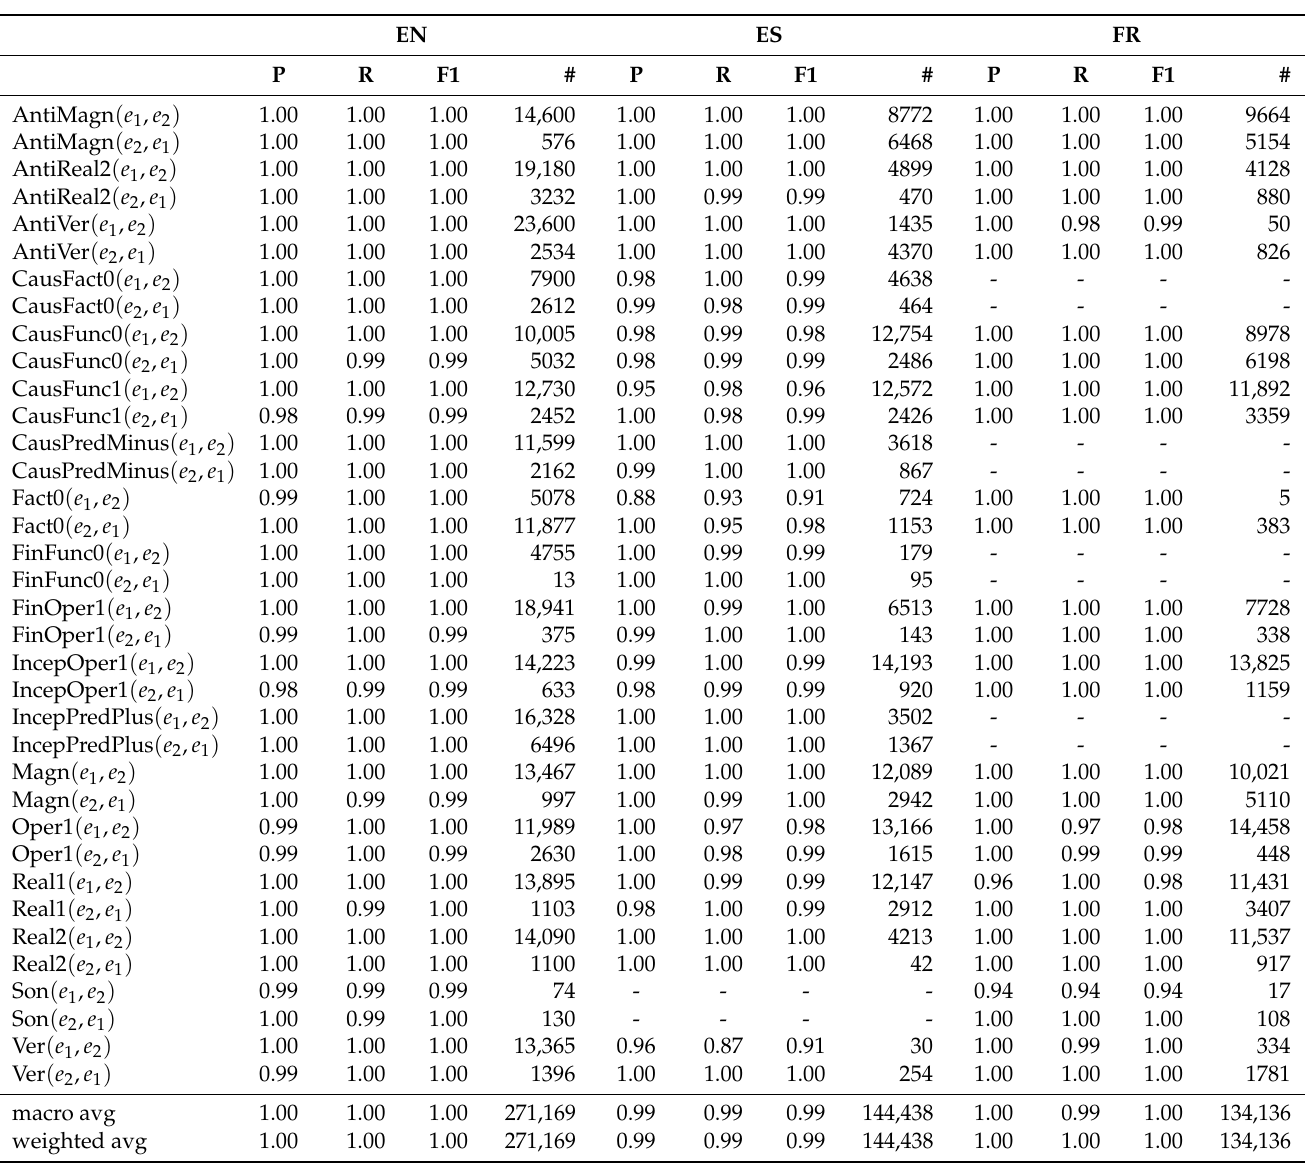
Table 3. Results breakdown per LF on the training set, where, for each LF, we list individual results for different order of bases and collocates in a